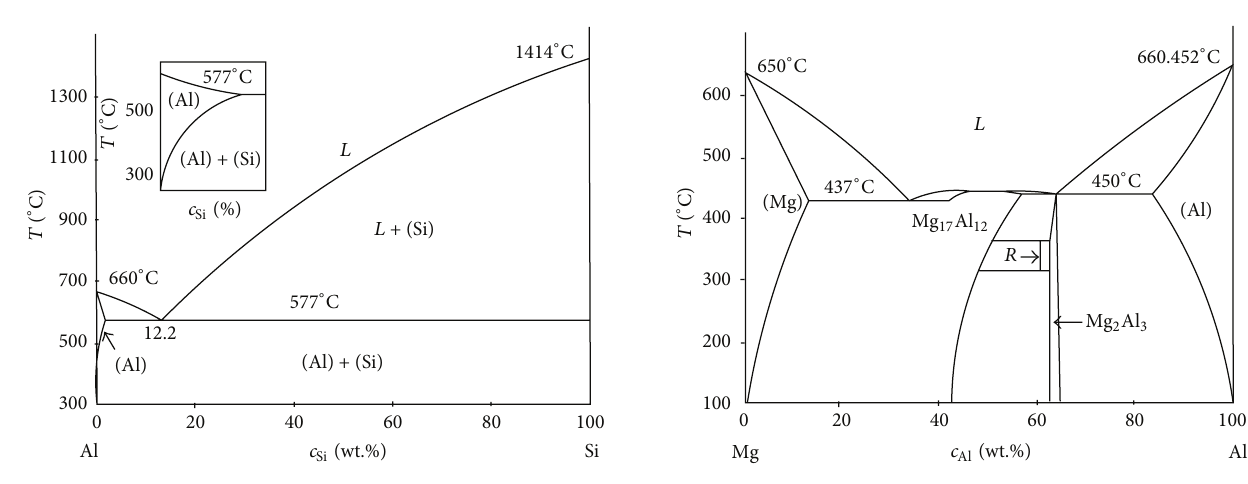
Figure 1: The Al-Si phase diagram [6]. Figure 2: The Mg-Al binary phase diagram